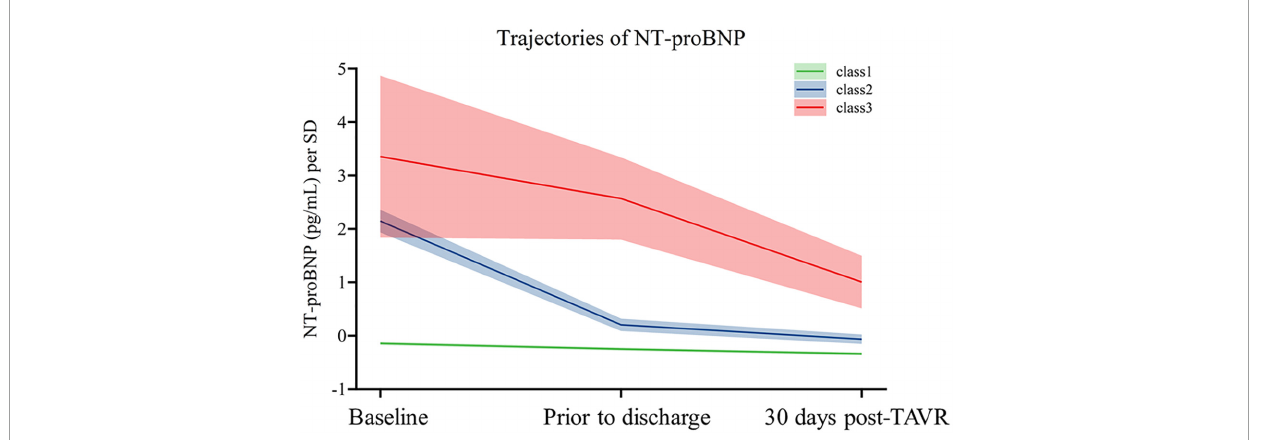
FIGURE1 Trajectories of NT-proBNP of the study population. The figure shows trajectories of NT-proBNP levels from baseline to 5-year post-TAVR from 857 individuals. Shading around the lines represents confidence bands for the calculated trajectory.